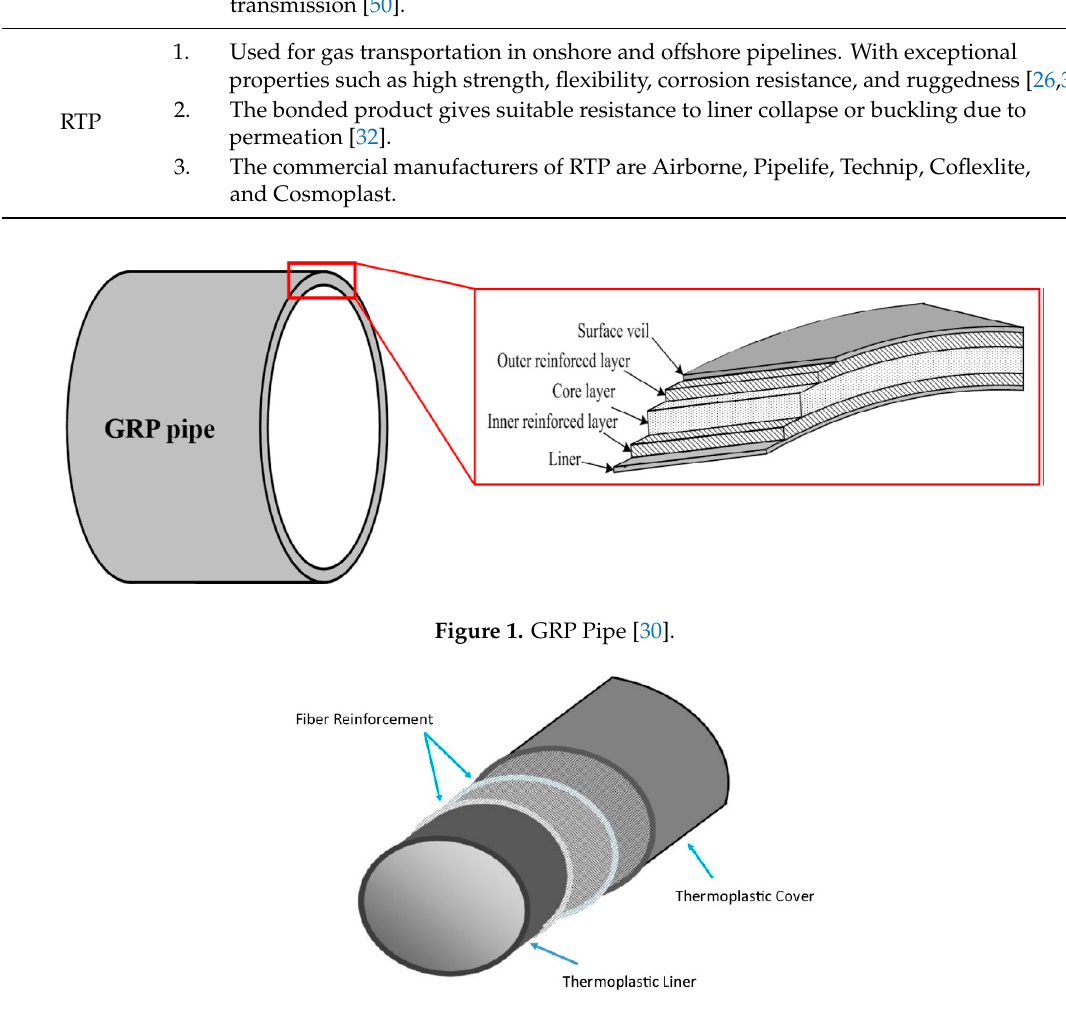
Figure 2. RTP structural components adapted from [31].